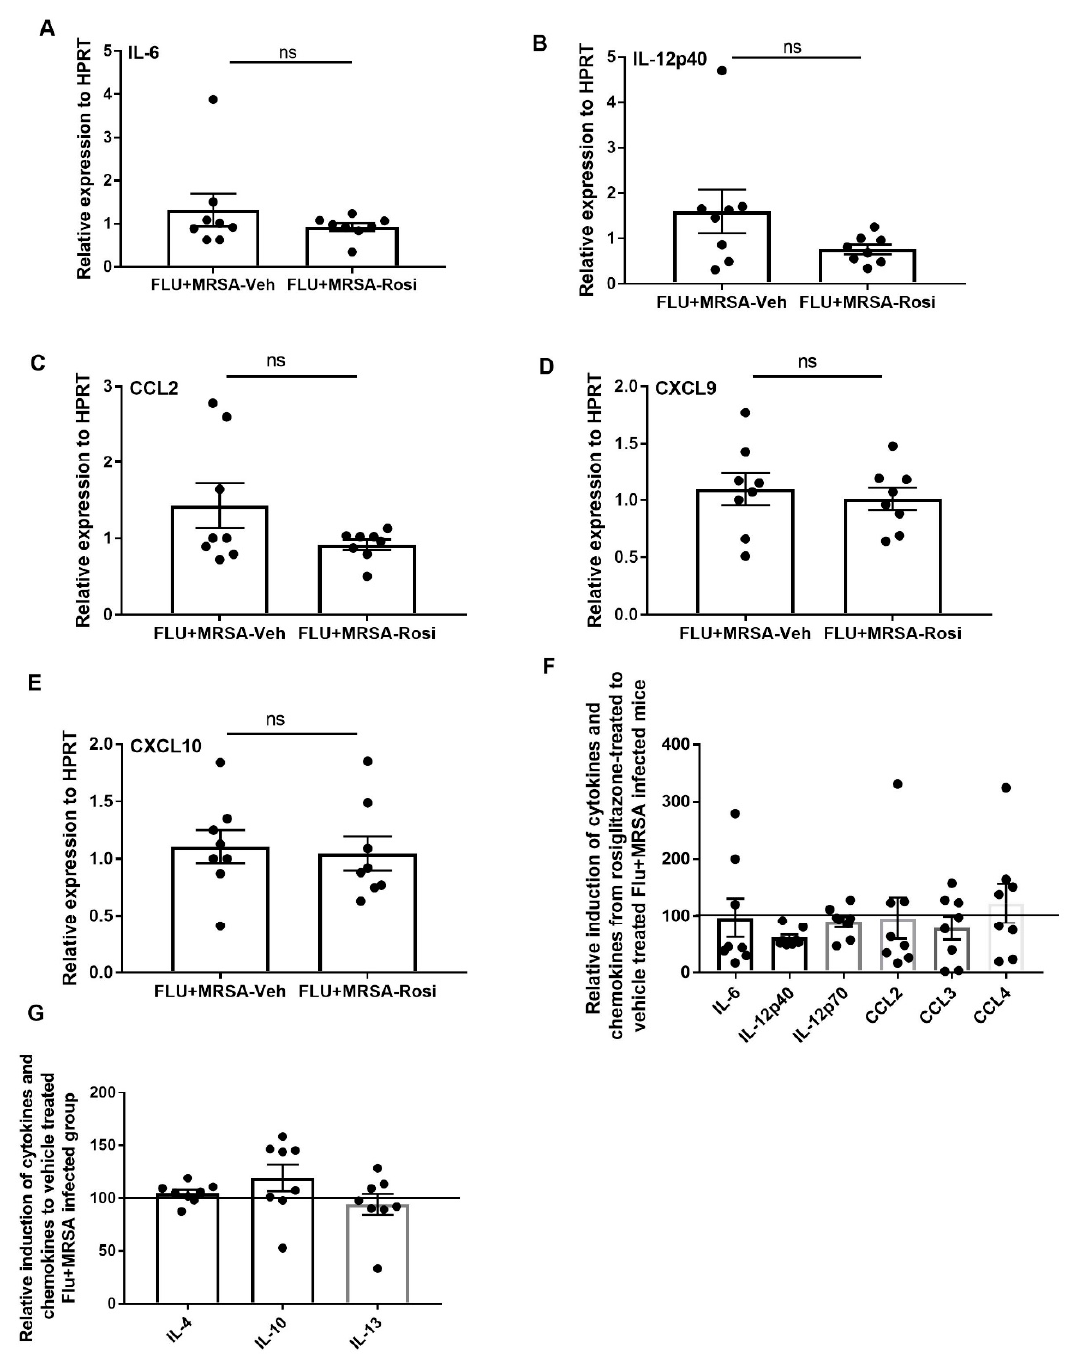
Figure 8. Rosiglitazone treatment does not a ff ect production of inflammatory cytokines and chemokines during influenza-bacterial super-infection. WT mice were infected with influenza or PBS for 6 days then challenged with MRSA for one additional day, and harvested one day after MRSA infection. Mice were treated with rosiglitazone or vehicle (DMSO) from day 0–6 of influenza infection or PBS treatment, ( N = 7–8 per group). ( A – E ) IL-6, IL-12p40, CCL2, CXCL9 and CXCL10 expression levels were measured by RT-PCR, N = 7–8 per group. Relative induction of ( F ) IL-6, IL-12p40, IL-12p70, CCL2, CCL3, and CCL4 ( G ) IL-4, IL-10 and IL-13 levels in response to rosiglitazone-treated to vehicle-treated group by Luminex assay N = 7–8 per group, Data are represented as mean ± SEM, ns-not significant.